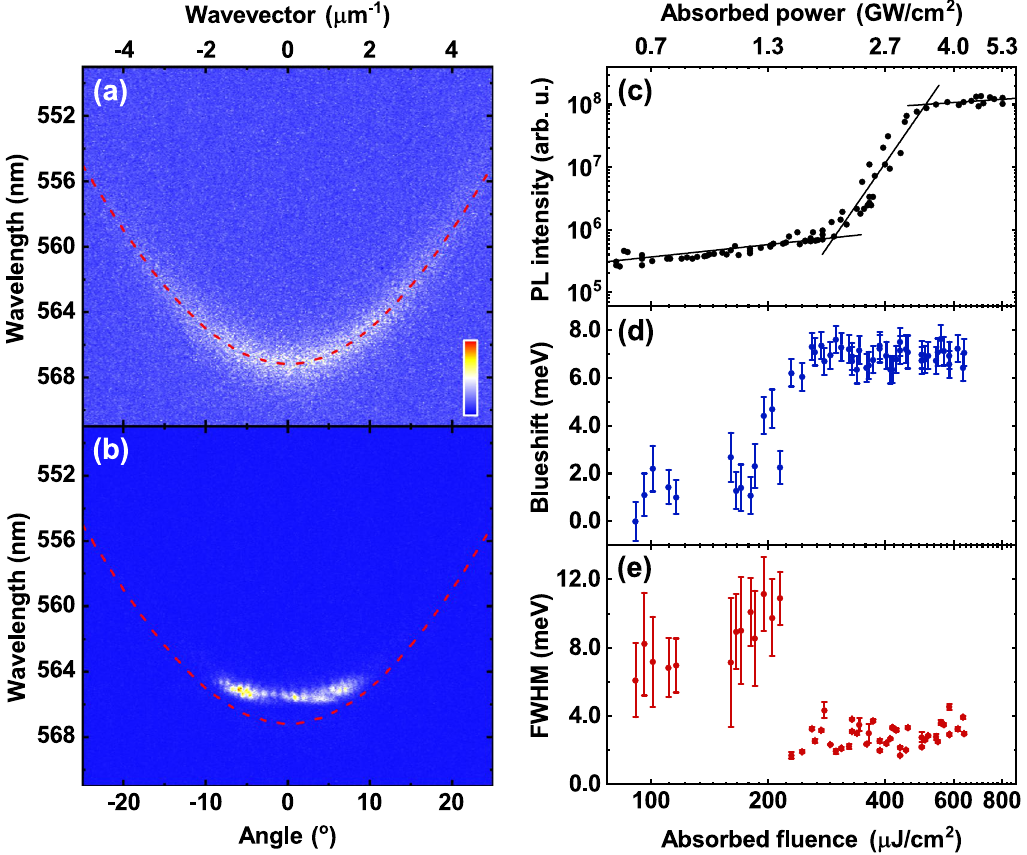
Figure 4. 1-pair hybrid mirror cavity condensation results. Normalised dispersions taken ( a ) below threshold and ( b ) above threshold. In both cases the red dashed line is a fit to the LPB in the linear regime. ( c – e ) Show the dependence of ( c ) PL intensity, ( d ) blueshift, and ( e ) full-width at half-maximum (FWHM) of the LPB on the absorbed pump fluence. From straight line fits to the power-dependent PL intensity in ( c ) (black solid lines), we determine a condensation threshold for this cavity of 295 μJ/cm 2 . Here we see a non-linear increase in PL intensity, a spectral blueshift, and a decrease in the FWHM of the LPB. The error bars in ( d ) and ( e ) were calculated from the error on a Gaussian fit to the LPB at each